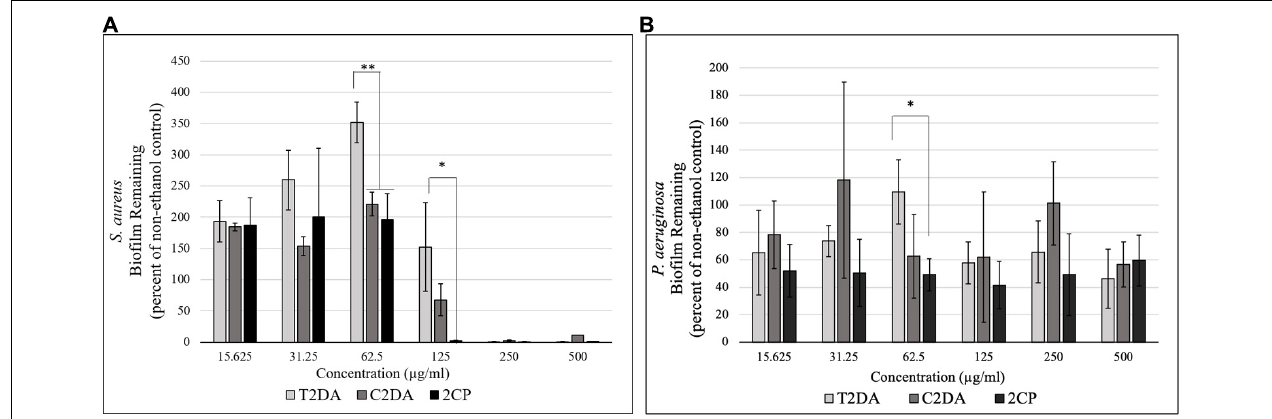
FIGURE 1 | Graph showing the percentage of (A) S. aureus and (B) P. aeruginosa biofilm remaining after 1 h of exposure to T2DA, C2DA, and 2CP. Asterisks represent significantly less biofilm remaining compared to T2DA ( ∗ p < 0.05, ∗∗ p < 0.01), detected by one-way ANOVA with the Holm–Sidak post-hoc test. Data represent mean ± standard deviation. TABLE 1 | S. aureus fractional inhibitory concentration index values. MBIC for 2CP (alone) MBIC for 2CP MBIC for antibiotic ( µ g/ml) (combined) ( µ g/ml) (alone) ( µ